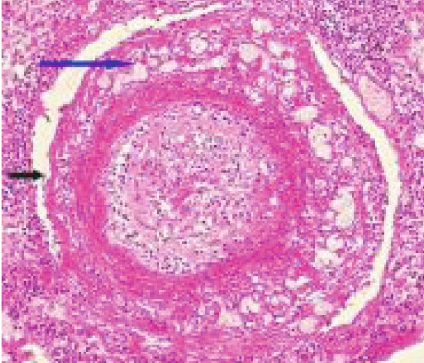
Figure 28: Pulmonary artery segmental arterial mediolysis reparative phase, early. An almost circumferential fl orid proliferation of young granulation tissue with widely dilated irregularly con fi gured capillaries having an angiomatous appearance (blue arrow) is evident between the adventitia (black arrow) and outer media. The arterial lumen is almost completed fi lled with a mixed population of endothelial cells, fi broblasts, and myo fi broblasts. Hematoxylin & eosin × 100 (adapted from Interventional Cardiology12(3) copyright 2020, online publication).